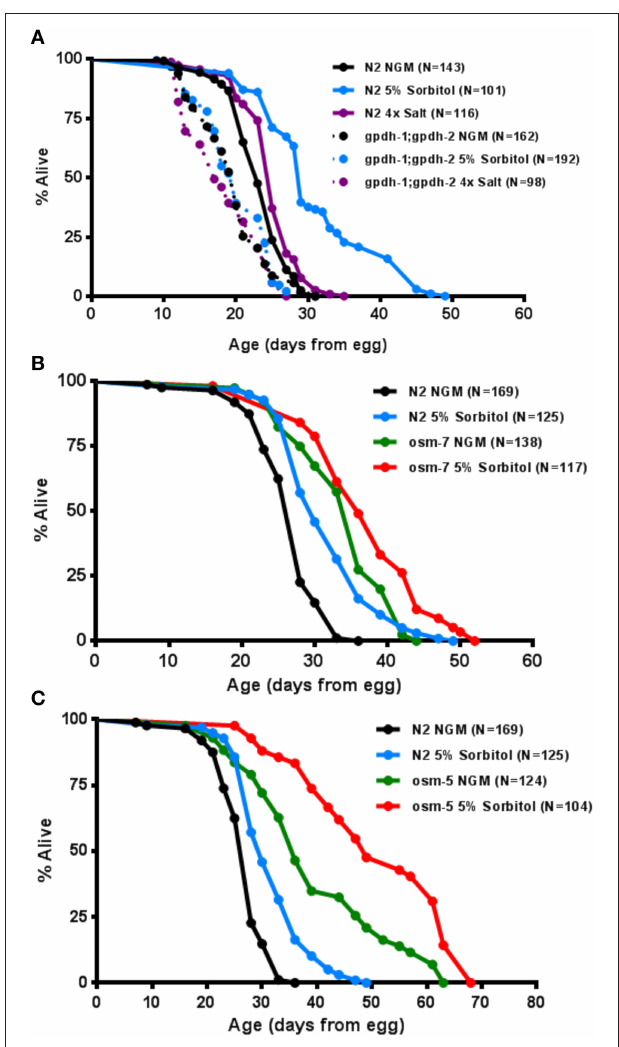
FIGURE 5 | The osmotic response pathway is associated with lifespan extension. (A) Genetic ablation of induced glycerol biosynthesis in the gpdh-1(ok1558);gpdh-2(kb33) double mutants prevents lifespan extension from 5% sorbitol. (B) Two mutations with constitutive activation of the osmotic stress response, osm-5(p813) and osm-7(n1515) , are long-lived under control conditions ( p < 0.001 , t